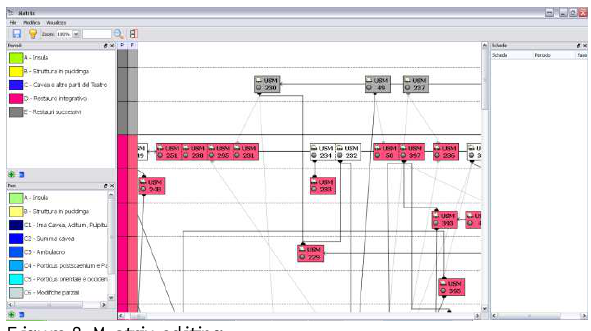
Figure 8. Matrix editing The system allow to check if all the UUSS are already inserted in the matrix, in order to avoid loss of data. In the matrix it is possible to associate period and phases to one sheet or to a group of UUSS. Automatically each UUSS are updated with the new information derived from the matrix. As each UUSS is georeferenced and linked to true orthophotos, drawings and 3D models it is possible to build a 3D matrix view, according to 3d georeferencing and timing.